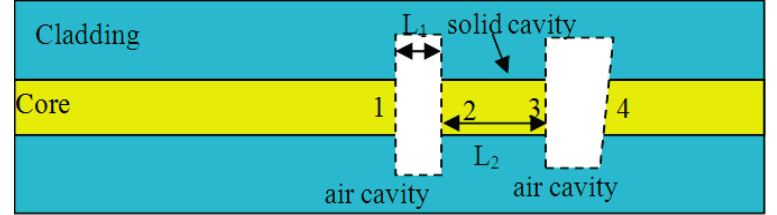
Figure 1. Structure of the sensor head, showing an in-fiber intrinsic F-P cavity and two air cavities, where the numbers “1”, “2”, “3” and “4” label are the four reflection surfaces in the structure.